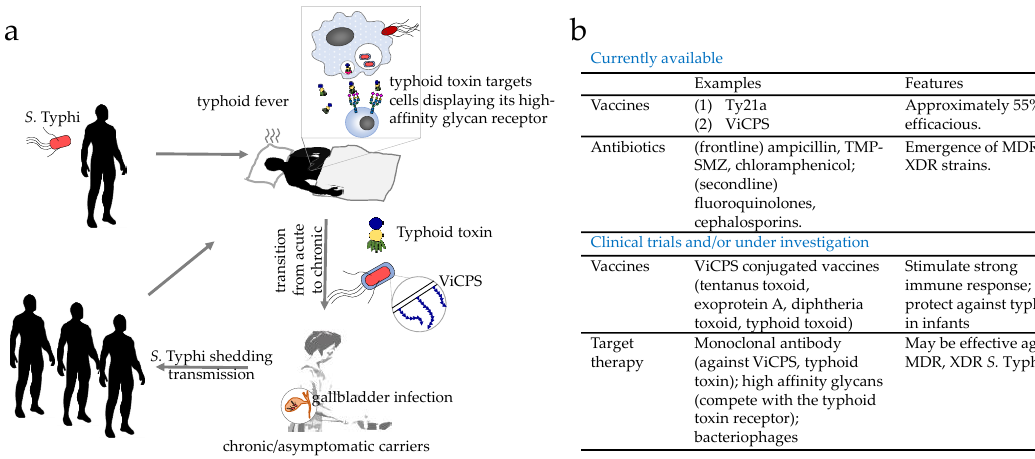
Figure 1. A cartoon depicting S. Typhi infection, disease development, transition from acute to chronic/persistent infection, and transmission. ( a ) Notable virulence factors (e.g., typhoid toxin and Vi capsular polysaccharide (ViCPS) of S. Typhi in disease development and transition from acute to chronic are discussed in Section 3. ( b ) A summary of prevention and therapeutic strategies against typhoid fever (details are discussed in Section 4).